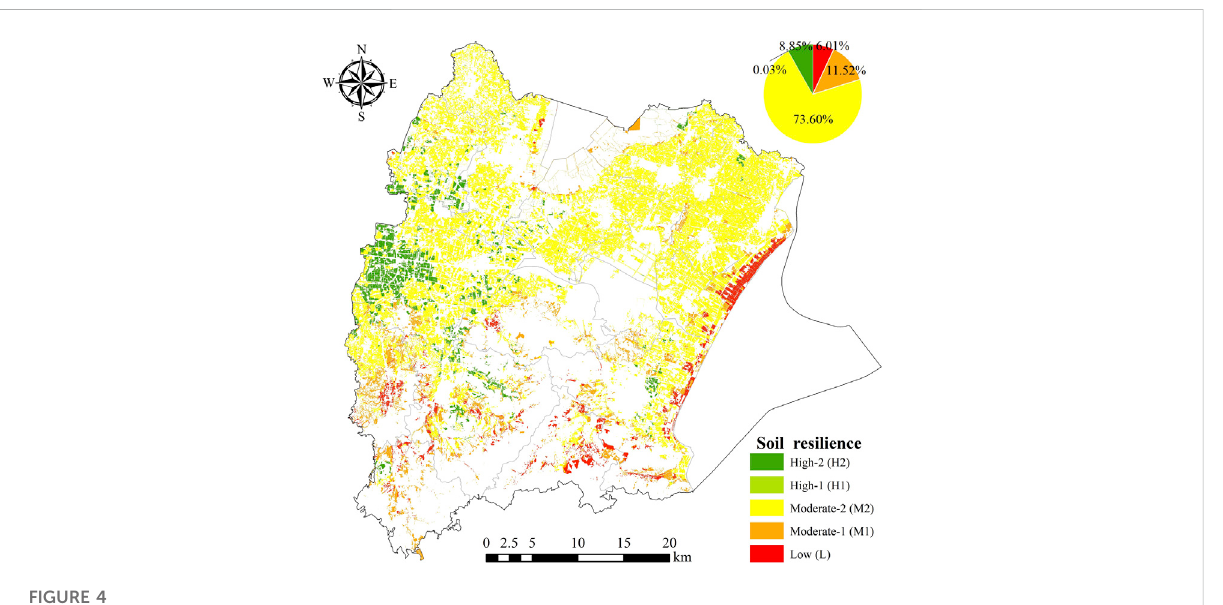
FIGURE 4 Distribution of soil resilience evaluation